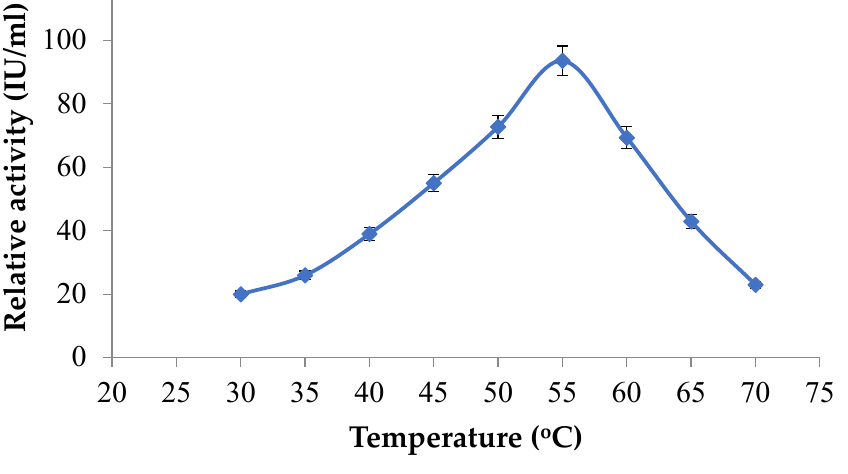
Figure 4. Effect of temperature on enzyme activity.